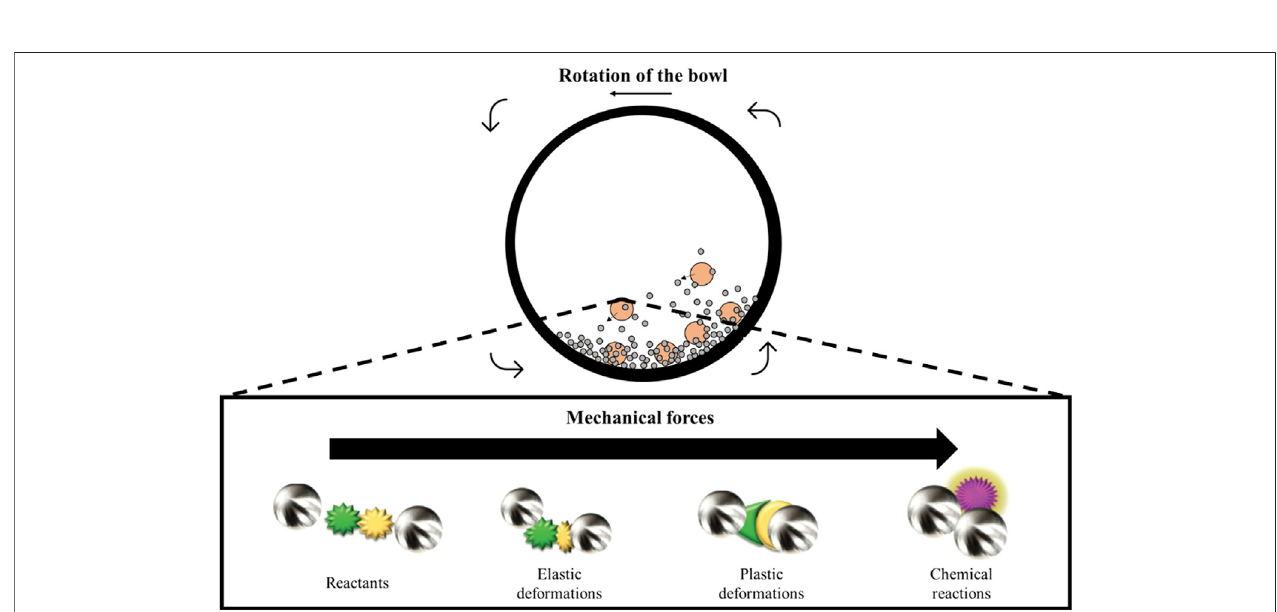
FIGURE5| Schematicrepresentationoftheballmotioninsidetheball-millingandillustrationofdeformationandreaction inmechanochemicalprocesses(Xuetal., 2015).